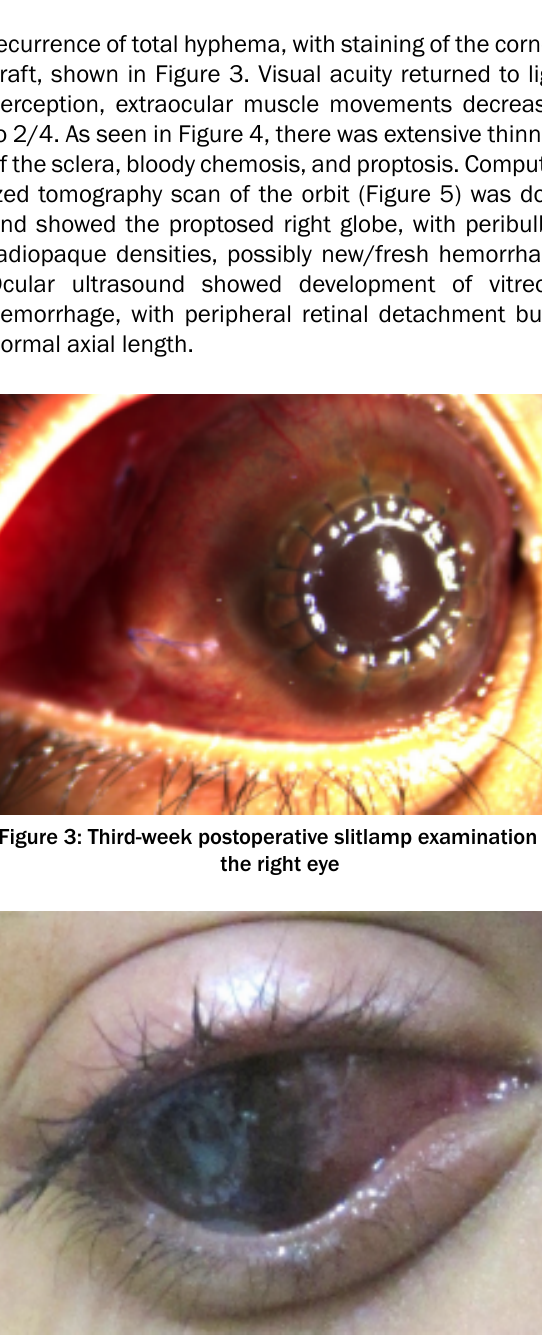
Figure 6: Family genogram showing X-linked inheritancepattern of bleeding